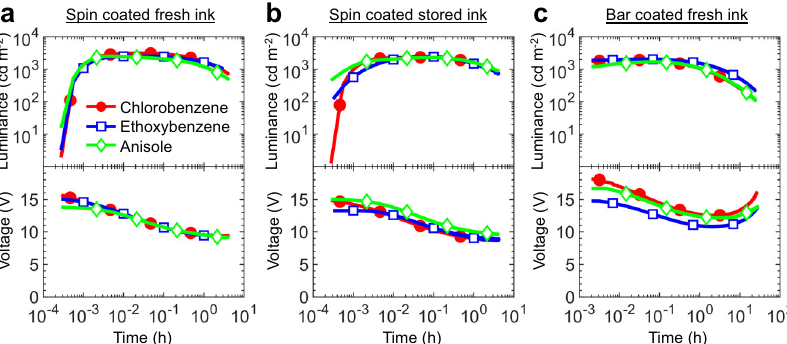
Fig. 2 LEC performance as a function of ink solvent, ink storage and ink depostion method. The temporal evolution of the luminance and the voltage for LECs fabricated from inks based on chlorobenzene (solid red circles), ethoxybenzene (open blue squares) and anisole (open green diamonds). a The performance of LECs fabricated by spin coating “ fresh ” inks (prepared the same day). b The performance of LECs fabricated by spin coating “ old ” inks, which had been stored for 30 days following ink preparation. c The performance of LEC fabricated by scalable bar coating. All devices were driven by a constant current density of j = 77 A m −